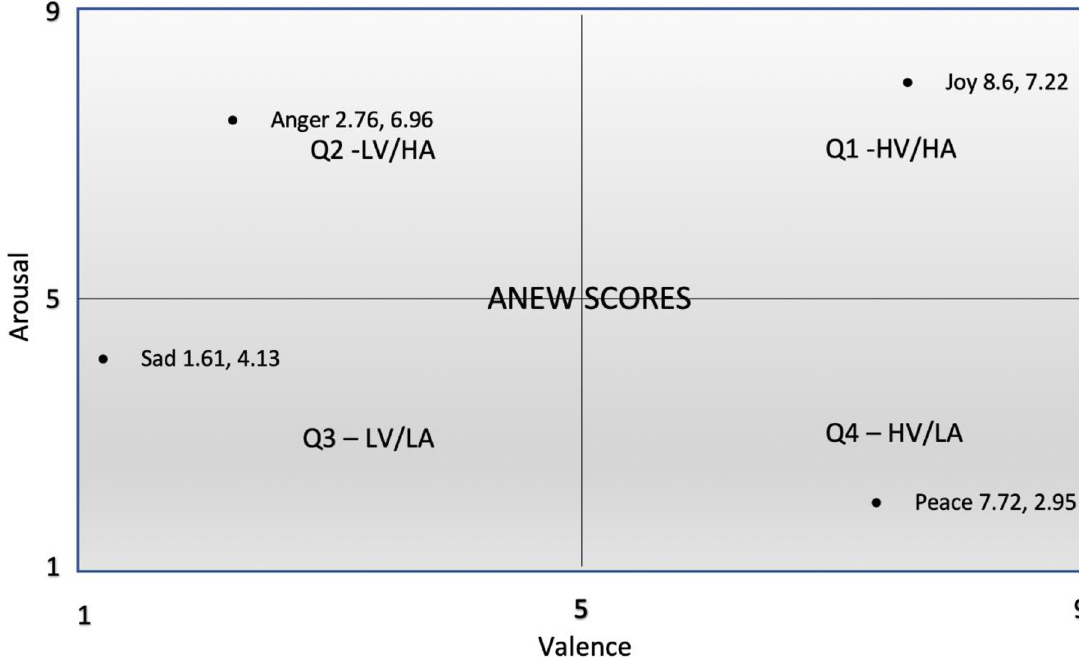
Fig 2. Two-dimensional emotion space showing regions used to define emotion categories described in Table 3. QX—YV/ZA refers to the rectangular region in quadrant X and its Y Valence and Z Arousal range. Valence and arousal scores of each emotion word are based on ANEW scores. Four sample emotion words are plotted, one belonging to each quadrant—Joy, Anger, Sad and Peace—for the purpose of illustration.